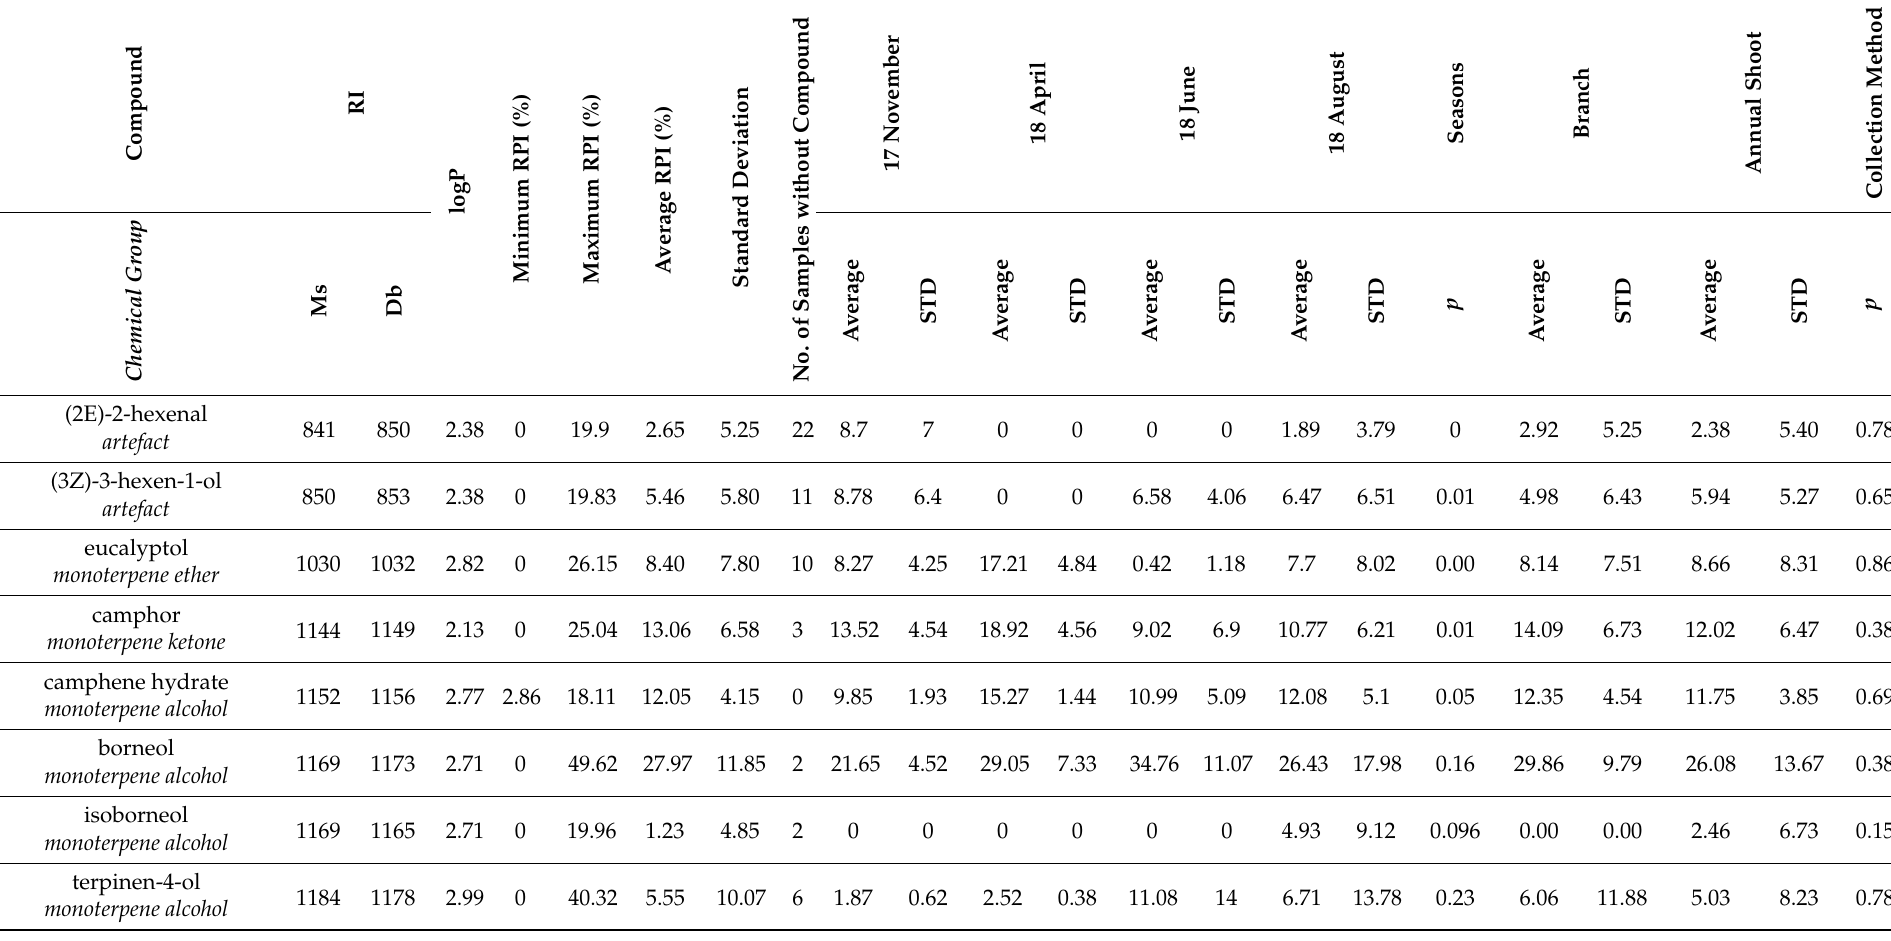
Table 3. List of volatile compounds whose average abundance according to their relative peak intensity (RPI) (Area %) in 32 hydrosol samples was greater than 1.2% with their log P, minimum, maximum, and average abundance obtained at different season times and with different plant parts with included p -value as detected by gas chromatography-mass spectrometry. The compounds were identified based on their mass spectra and retention indices (RI; Db, database RI; Ms, measured